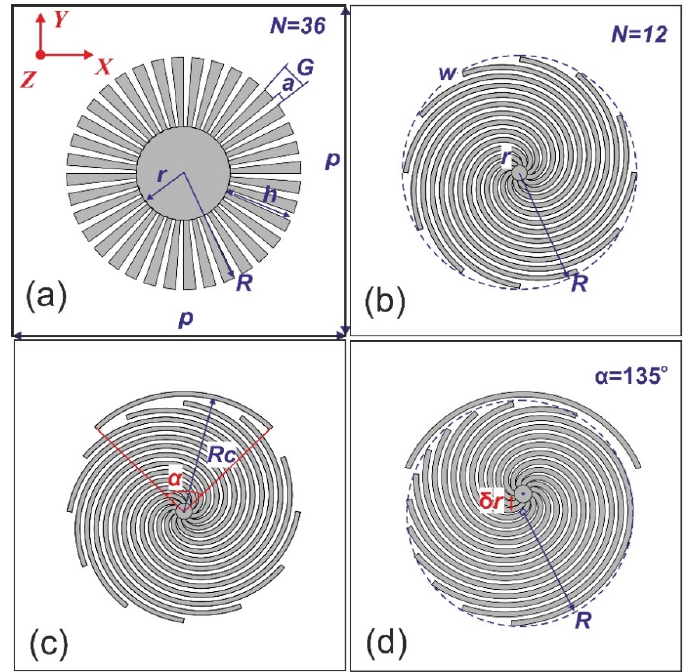
Figure 1. Four different designs of plasmonic metasurfaces (PMSs) with the metal disk elements (the unit cells are shown; p is the lattice constant): ( a ) the azimuthally patterned disk; ( b ) the spiral disk; ( c ) the spiral disk with a C-shaped resonator ( α is the resonator’s arch angle); ( d ) the spiral disk with a C-shaped resonator and a shifted center ( δ r is center shift).